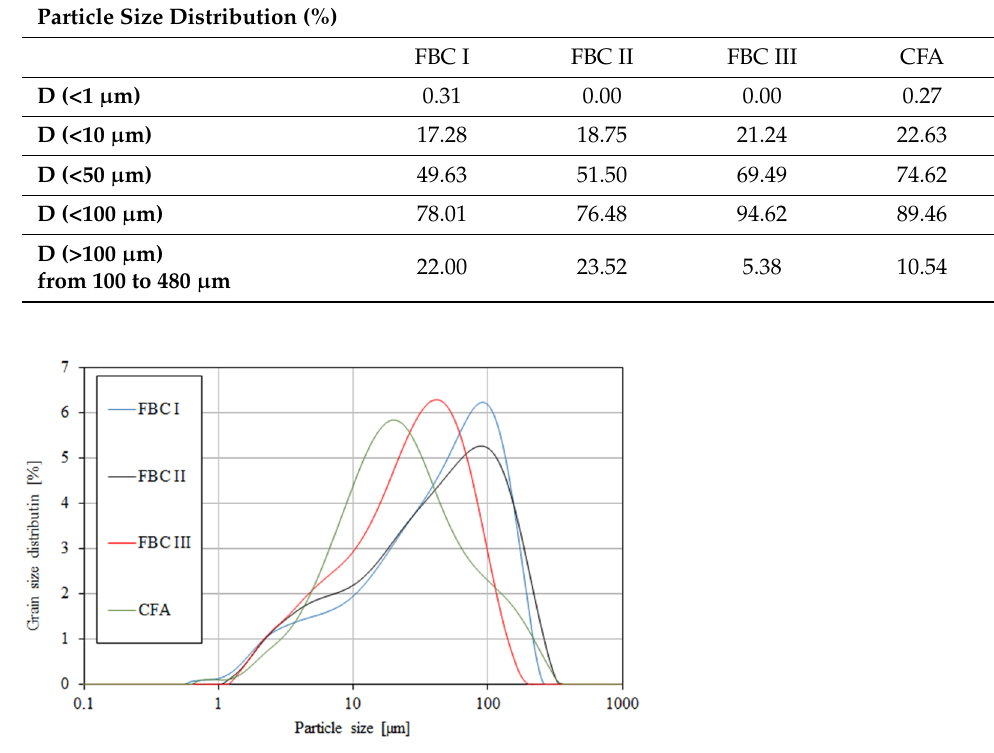
Figure 5. Particle size distribution of fluidized fly ash (FBC I, FBC II, FBC III) and conventional fly ash (CFA).